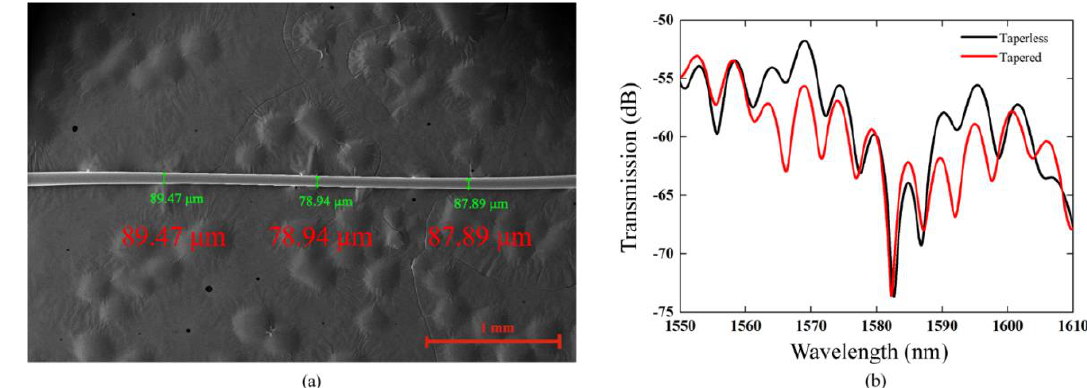
Figure 3. ( a ) SEM image of the tapered-TCF. ( b ) Transmission spectrum of the MZI sensor with and without tapering.